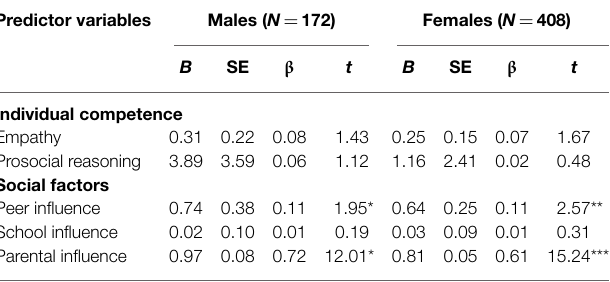
TABLE 6 | Prediction of prosocial behavior from individual competence and social influence factors for males and females